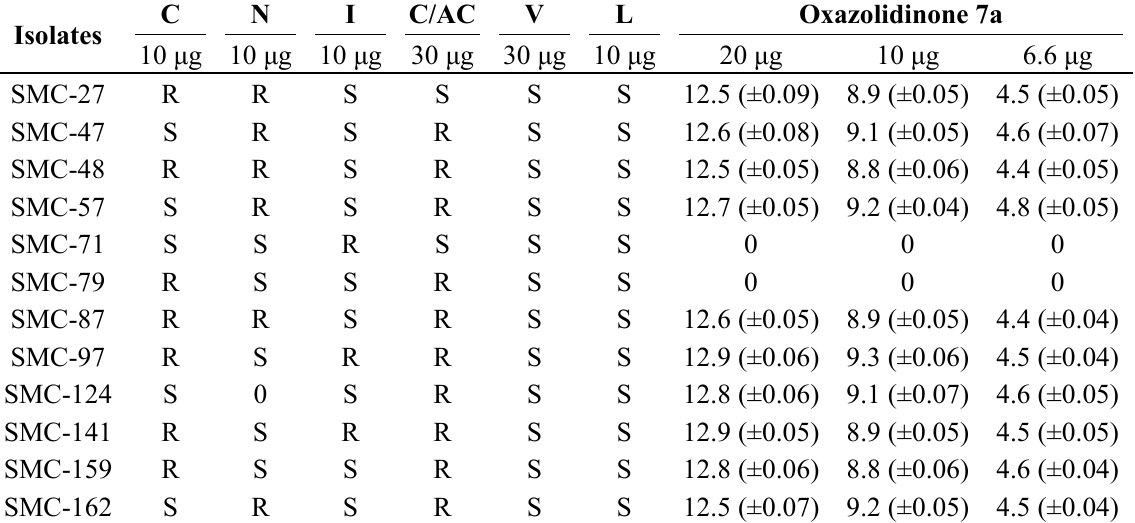
Table 2. Inhibitory activity (mm) of standard antibiotics * and 7a oxazolidinone analogue on growth of methicillin resistant S. aureus (MRSA) clinical isolates (means ± SD, n = 3).